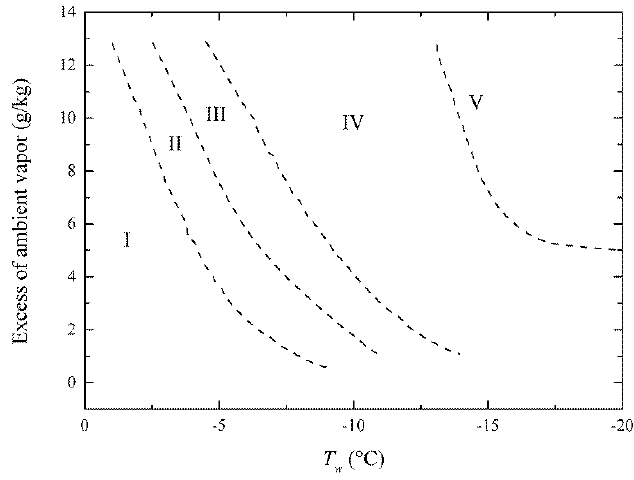
Figure 1. Illustration of frost morphology on the flat plate from Wu et al. [16]. I: super-cooled water droplets, II: irregular crystals, III: flake crystals, IV: needle and pole crystals, and V: feather crystals.